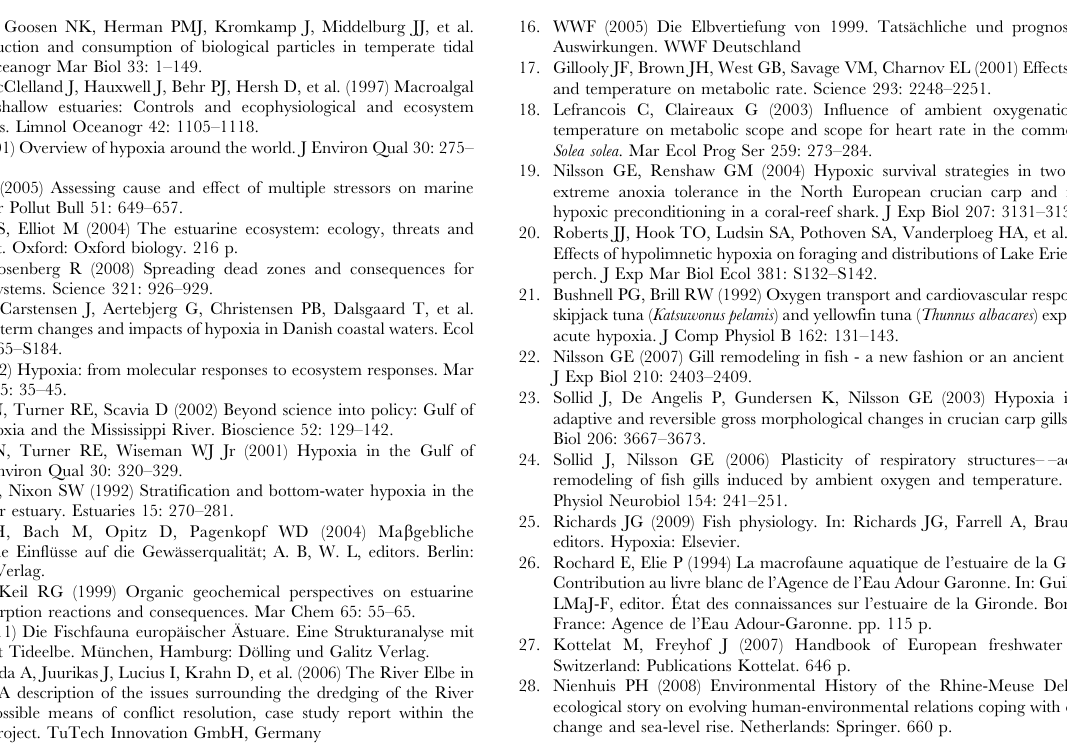
data. Table S4 MANOVA of qPCR data. A. Effects of setups (field studies versus laboratory) on gene expression in the tissues of ruffe using Pillai’s trace statistics. B. Effects of species specificity on gene expression within a tissue and referred to one hypoxic condition using Pillai’s trace